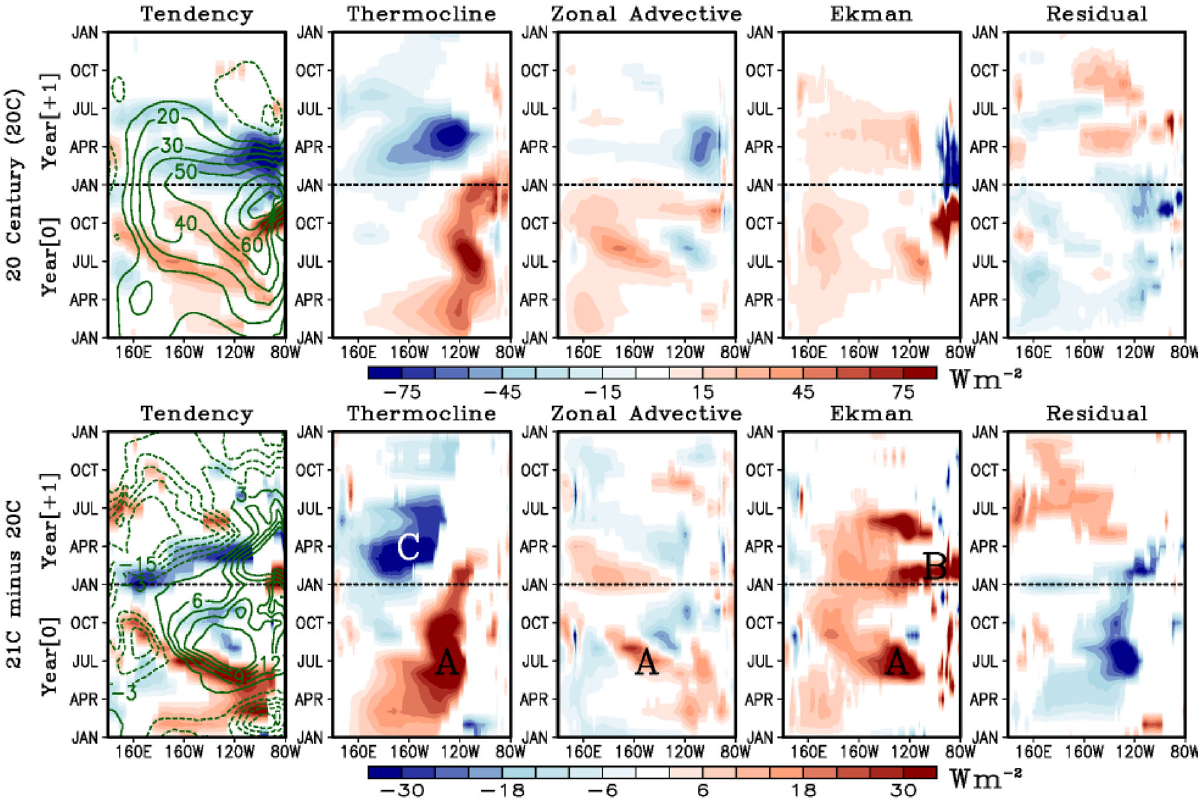
Fig. 2 Mixed layer heat budget analysis during El Niño events for CESM-LENS. The top row shows the composites for the heating tendency, thermocline feedback, zonal advective feedback, Ekman feedback, and residual term from Eq. 1 (color, W m − 2 ) and the heat content anomaly (green contours, 10 8 J m − 2 ) for the 20 th Century (20C). Bottom row shows the projected future change in the composite, for the 21 st minus the 20 th Century (21C). All terms are computed assuming a constant 75 m mixed layer depth. See text for references to points A, B, and C. Only showing composite anomalies exceeding the 95 th percentile signi fi cance level based on a bootstrapping technique (see